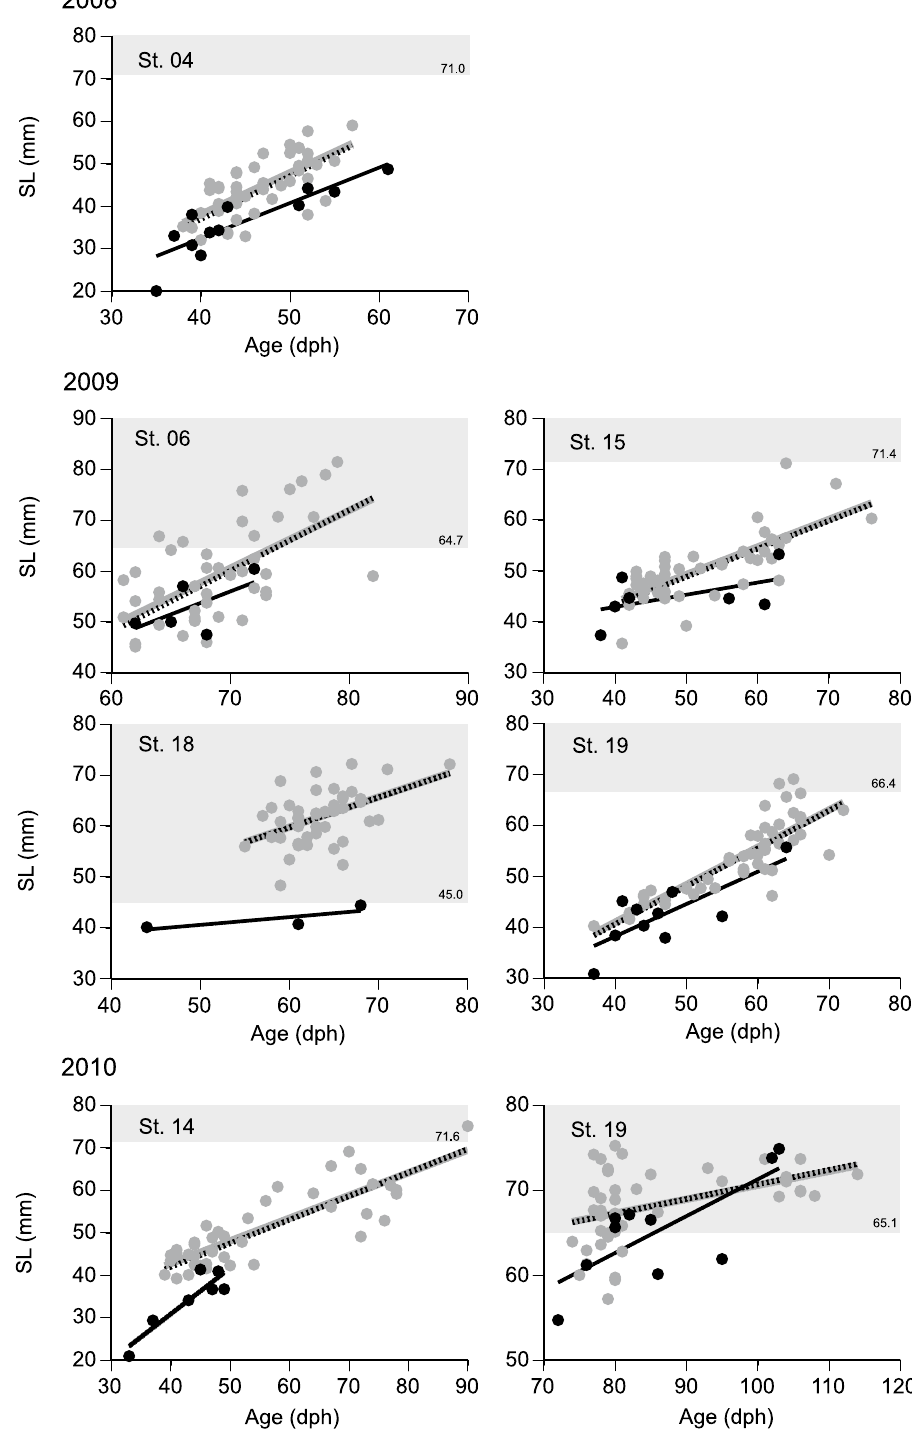
Figure 4. Relationships between standard length (SL) and age of the consumed (black circles) and the netted (grey circles) juveniles of Trachurus japonicus in the study sites. The thick solid grey and black lines indicate linear regression of the netted and consumed juveniles, respectively. Dotted black lines indicate the age–SL relationship taking into consideration net bias for the netted juveniles. Shaded area indicates potential SL ranges with the selective rejection of feeding by squids, which corresponds to a predator–prey mass ratio (PPMR) < 13.2. Numbers at the bottom right in the shaded area indicate the threshold SL of the potential selective